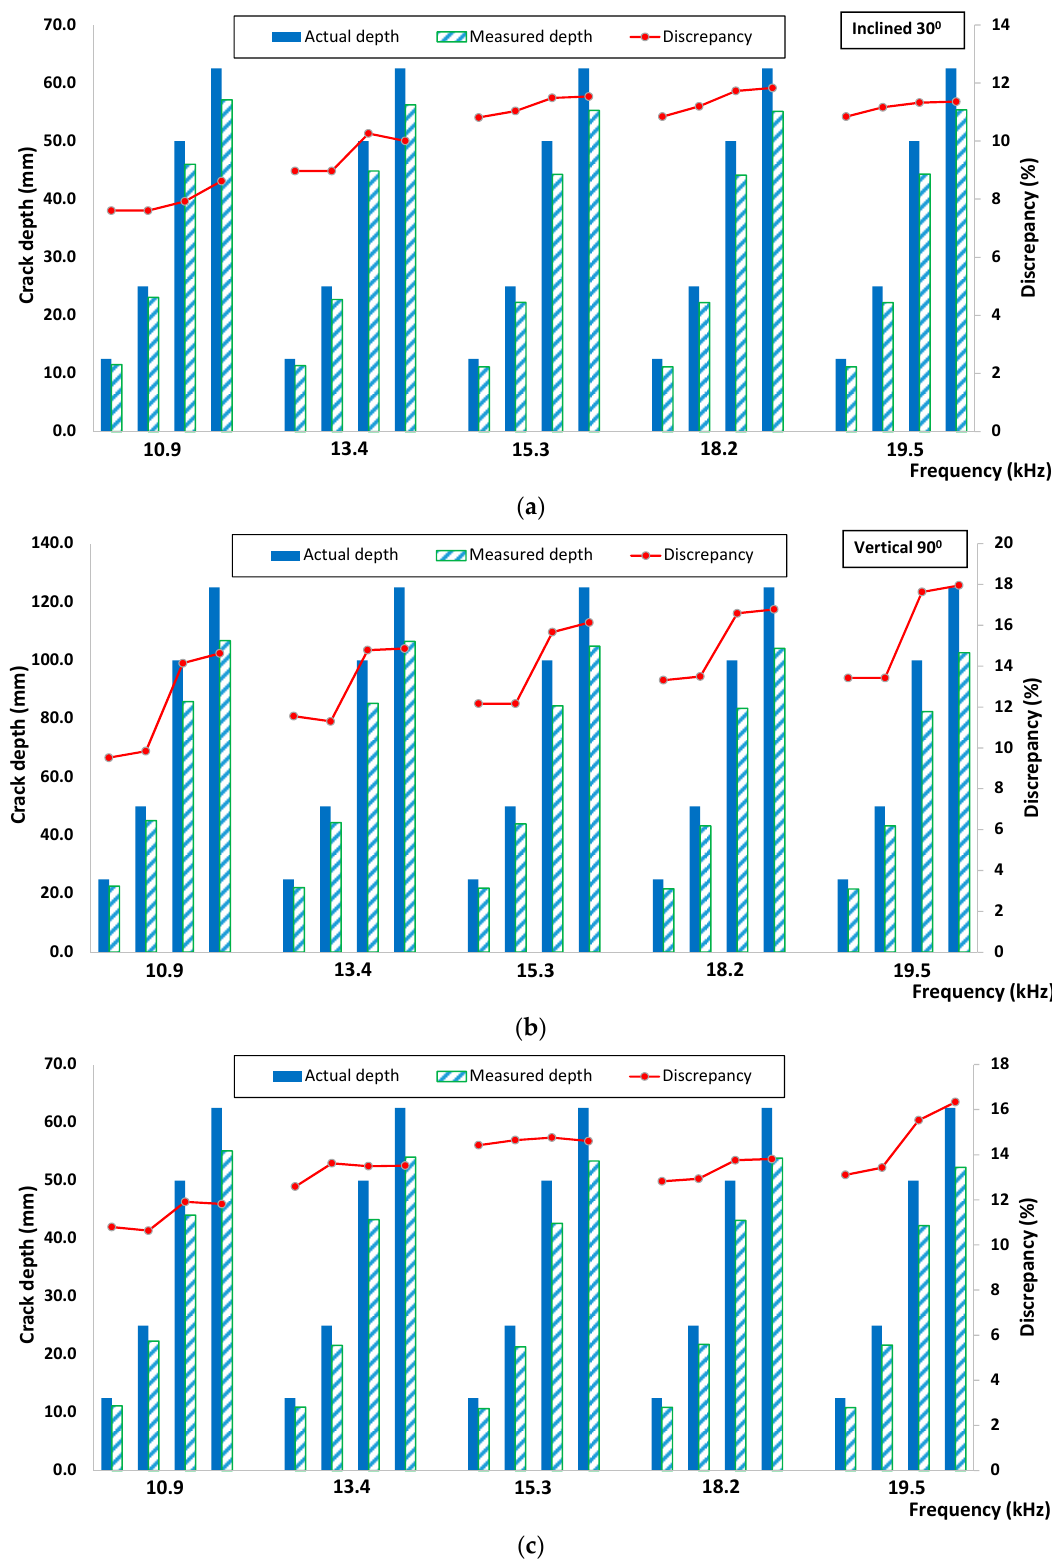
Figure 13. Comparison between actual and experiment measured crack depth based on velocity index for ( a ) inclined 30°, ( b ) vertical 90° and ( c ) inclined 150°.